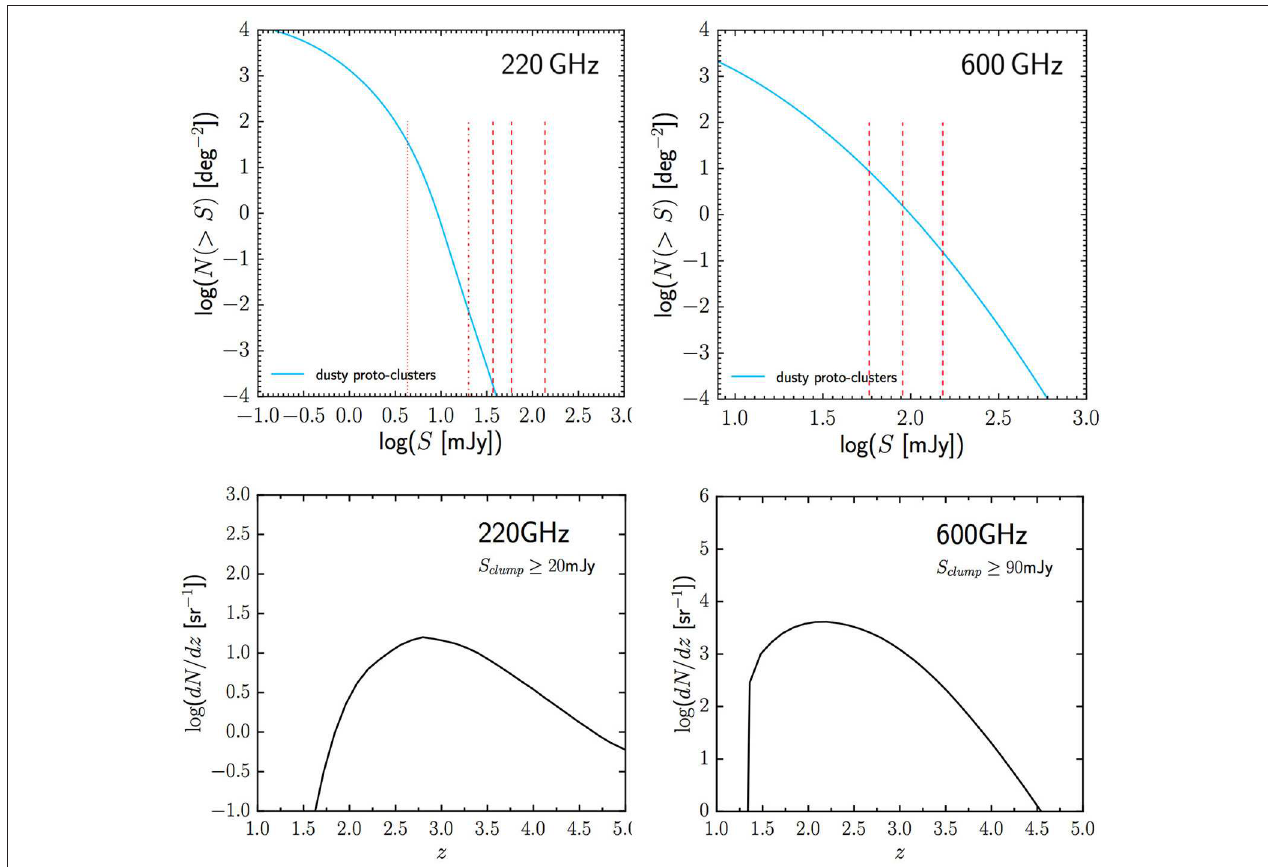
FIGURE 7 | Integral counts and redshift distributions of proto-clusters at 220GHz and 600GHz (1.4mm and 500 µ m, respectively) predicted by Negrello et al. (2017b) . The vertical lines in the upper left panel show, from left to right, the 5 σ confusion limit for a 6m telescope, the SPT completeness limit and the 5 σ detection limits for 2, 1.5 and 1m telescopes operating at the diffraction limit. Only the three latter limits, at 600GHz, are shown in the upper right-hand panel. The lower panels show the redshift distributions at the SPT completeness limit at 220GHz (20mJy, left) and at the 5 σ detection limit (90mJy) for a 1.5m telescope at 600GHz